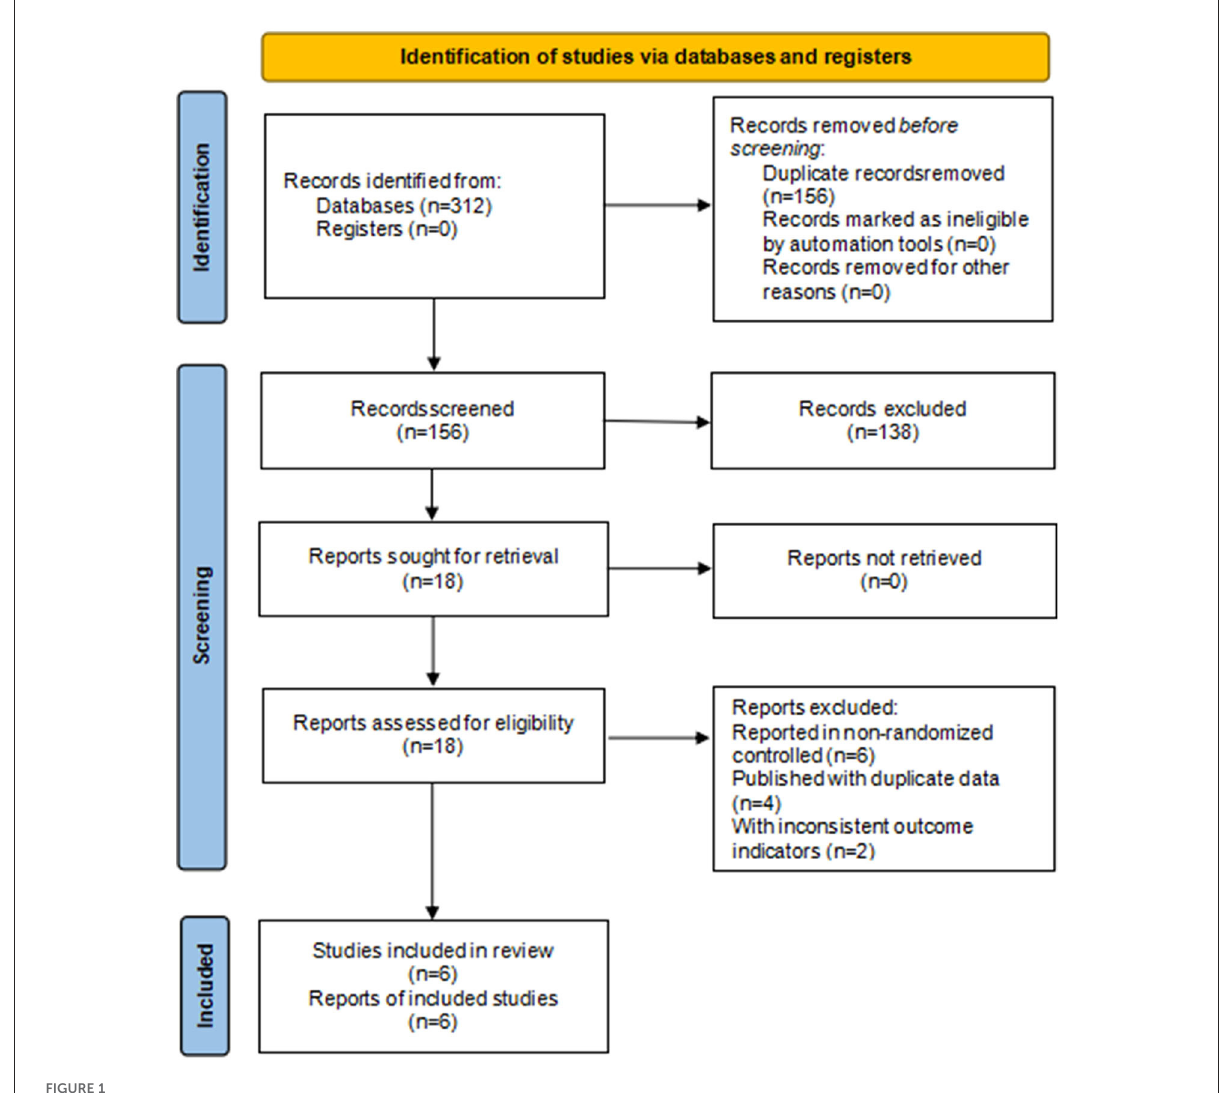
FIGURE1 Study flow